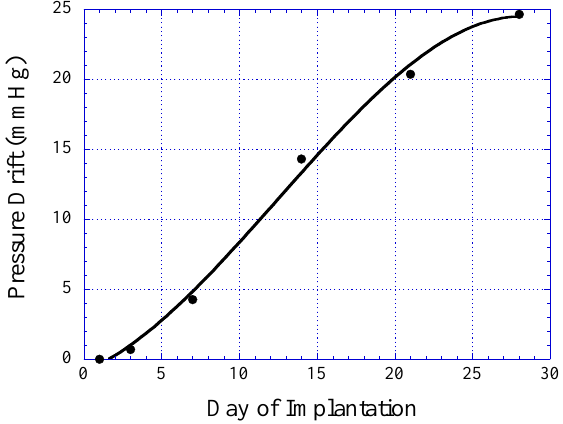
Figure 12. Plot illustrating the sensor drift of the magneto-harmonic pressure sensor in 28 days of implantation. The plot is generated using data points obtained from 14- and 28-day study groups.